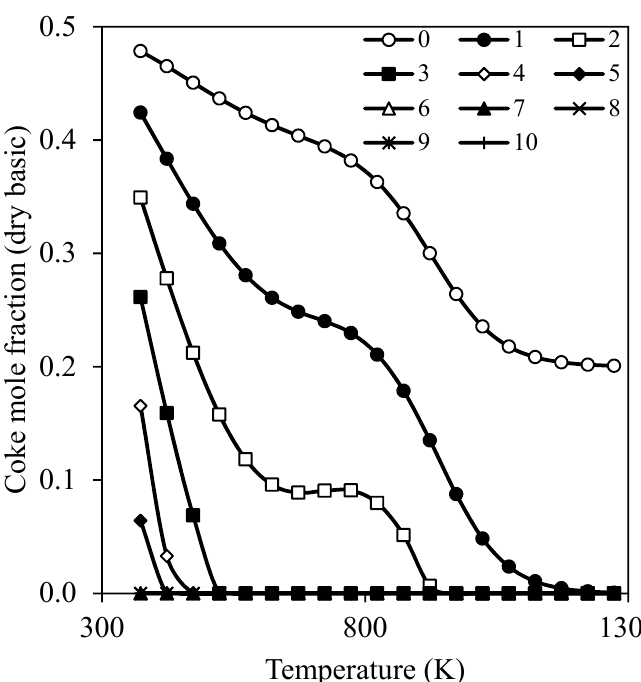
Figure 5. Coke formation at various steam to ethanol ratios and operating temperatures.